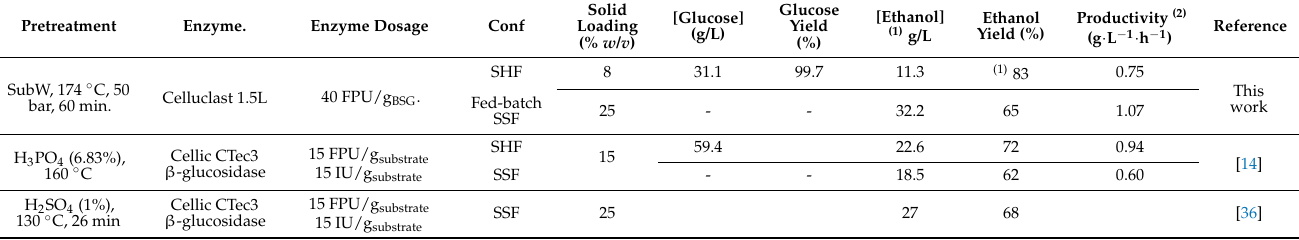
Figure 5. Evolution of ◇ pH and □ glucose, △ xylose, ○ ethanol, ∗ glycerol and x biomass concentrations (g/L) for fermentation from subW-pretreated BSG after enzymatic hydrolysis (48 h and 8% w/v ) in a SHF configuration during 48 h. Analytical measurements were conducted in triplicate. Table 2. Comparison between the results obtained for SHF (8% w/v ) and fed-batch SSF (25% w/v ) assays from pretreated BSG with S. cerevisiae in this work and in the literature.